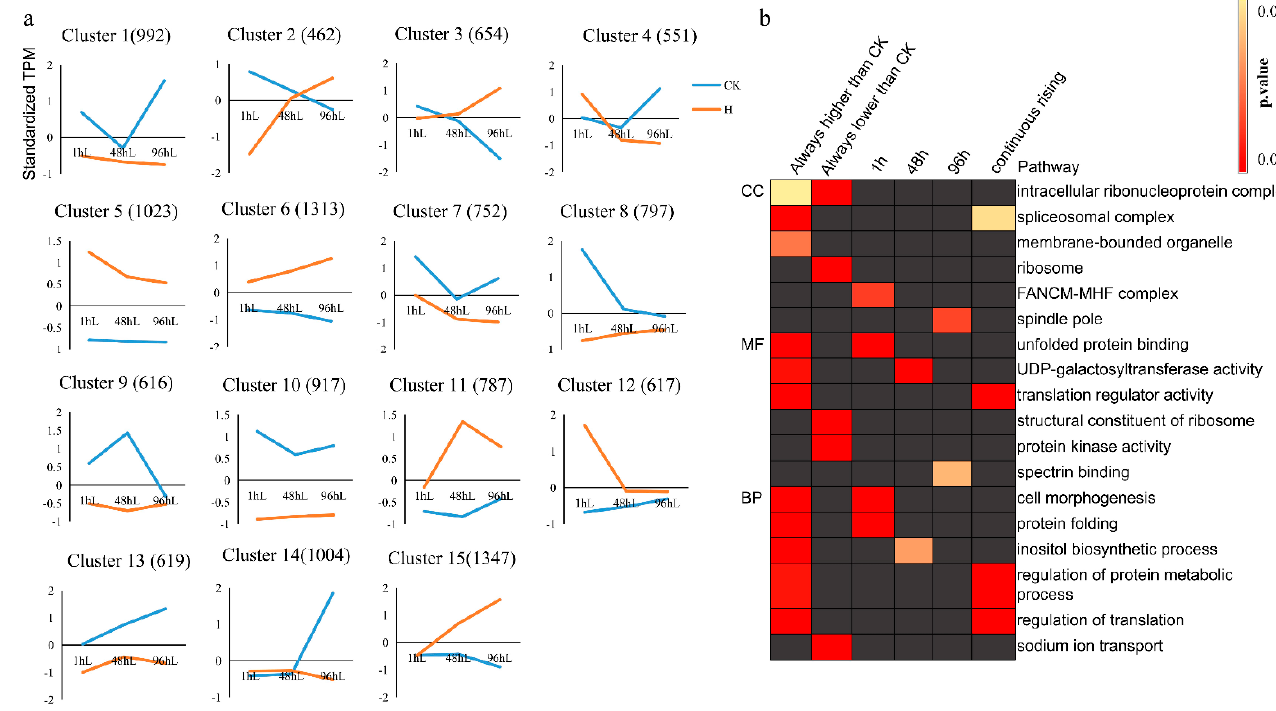
Figure 4. K-means analysis of DEGs. ( a ) Clustering of DEGs. ( b ) GO enrichment analysis after K-means clustering. The number in parentheses after Cluster indicates the number of DEGs. Gray represents not enriched.